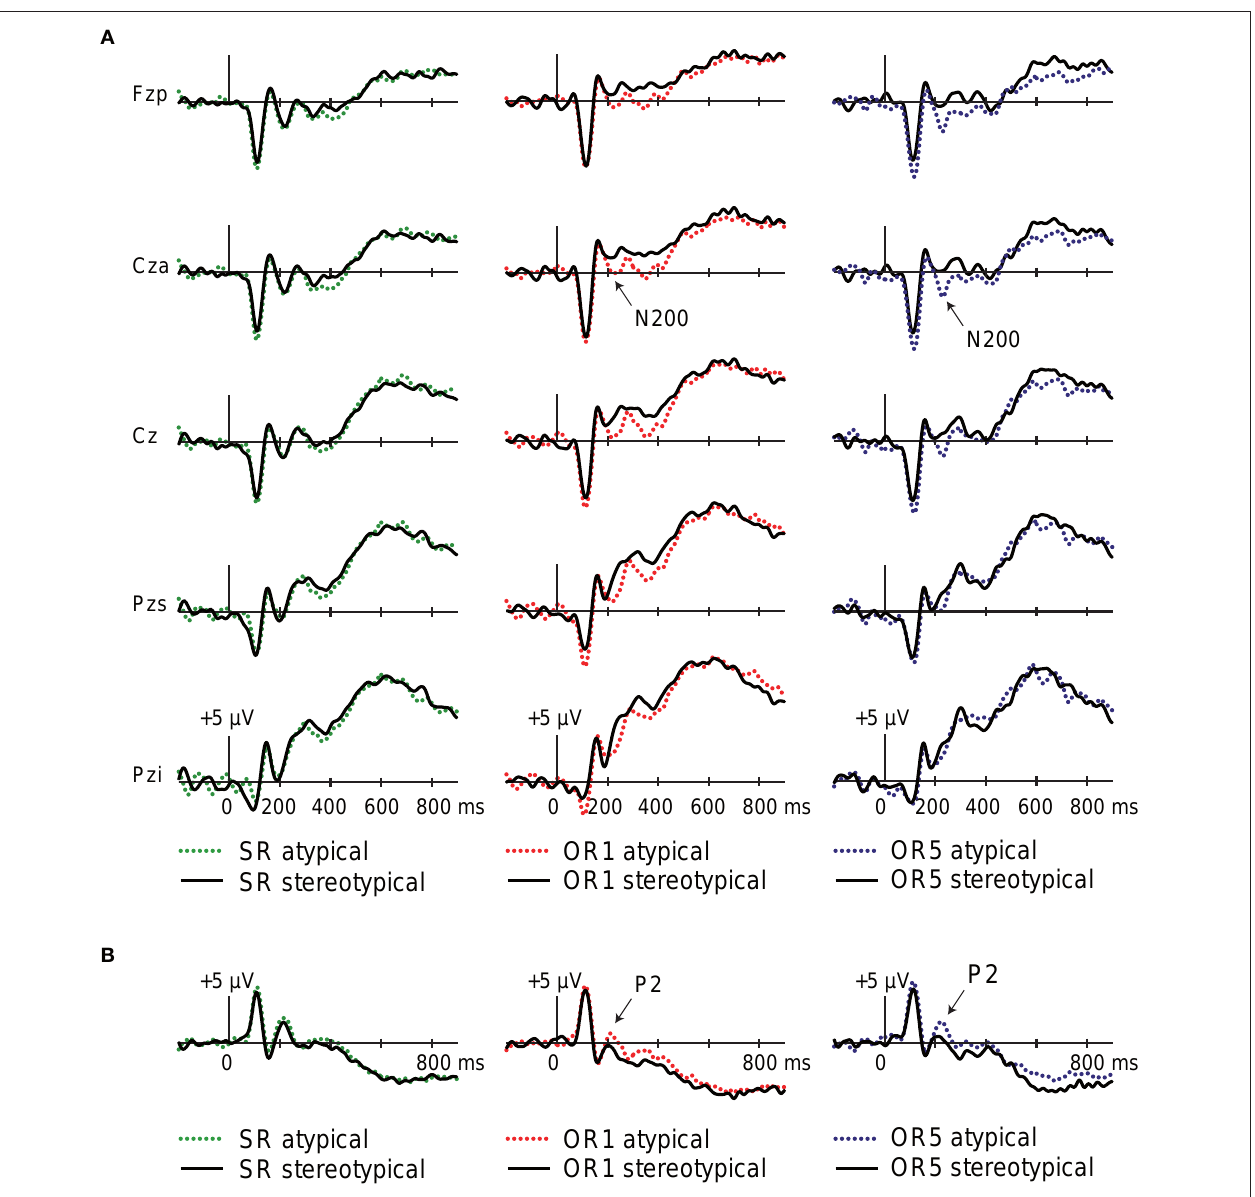
FiGuRE 6 | consensus race-typicality effects on midline ERPs. Trials were divided via a median split into high stereotypical faces and low stereotypical faces for SR, OR1, and OR5 conditions (left, center, and right, respectively). (a) Waveforms for the same five midline electrode locations depicted in Figure 3 . (B) Waveforms from right-occipito-temporal electrode T2i, computed using averaged-reference